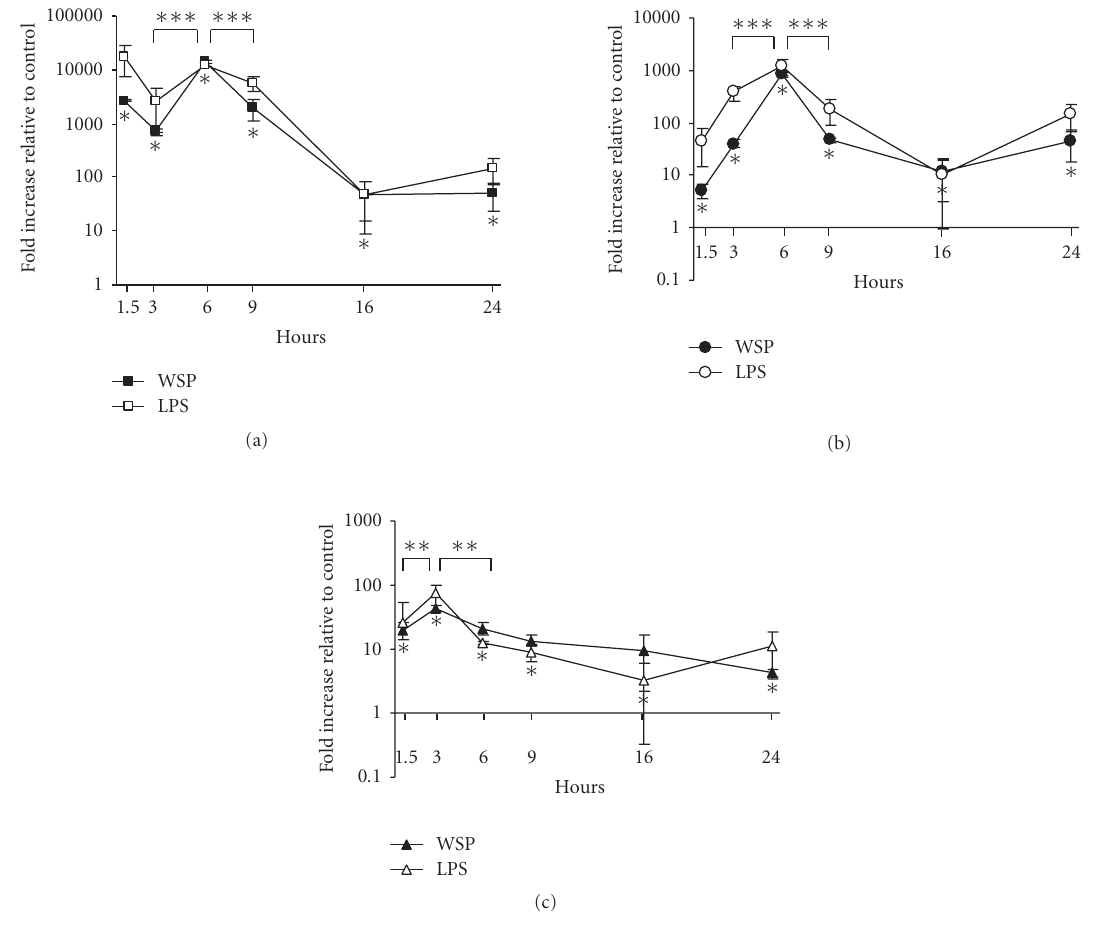
Figure 2: Time-course analysis of rWSP-induced IL-1ˆa (a), IL-6 (b), and TNF (c) mRNAs expression in murine macrophage RAW 264.7 cells. Incubation of the macrophage cells with 9.0 μ g/mL rWSP (black symbols) or 0.1 μ g/mL E. coli LPS (white symbols) were performed at various time-points. The data represent mean values and standard deviations of fold increase of cytokine transcripts relative to negative control in log scale. Significant di ff erences to untreated controls are indicated as ∗ P < . 05. ∗∗ Significant di ff erences were found between rWSP-stimulated cells at 1.5 hours and 3 hours postexposure as well as between rWSP-stimulated cells at 3 hours and 6 hours postexposure (for TNF mRNA levels; P < . 05), while ∗∗∗ significant di ff erences were found between rWSP-stimulated cells at 3 hours and 6 hours postexposure as well as between rWSP-stimulated cells at 6 hours and 9 hours postexposure (for IL-1 β and IL-6 mRNA levels; P < .